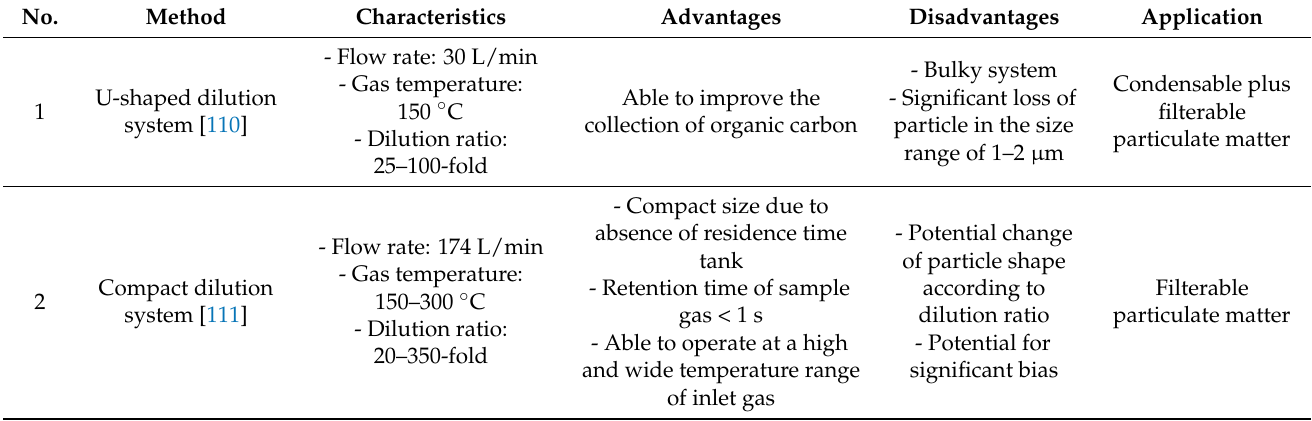
Table 4. Development of dilution systems for particulate matter